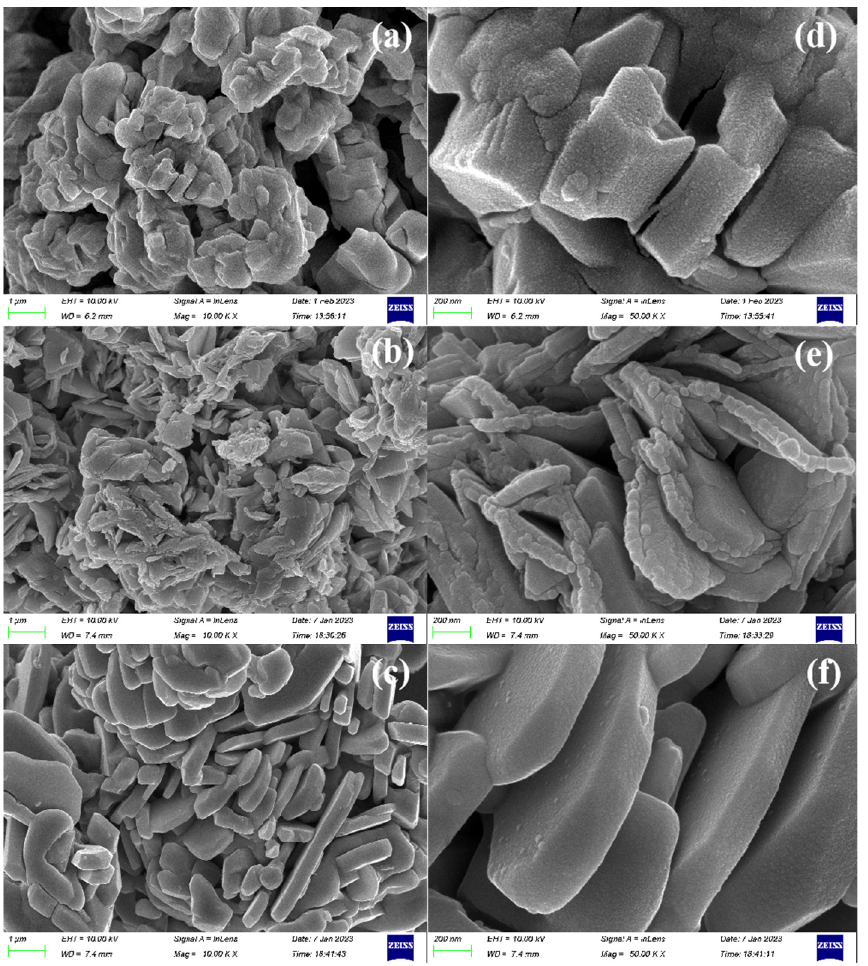
Figure 2. SEM images of Cu/MoO x samples with different atomic ratios of Cu/Mo ( a , d ) 1:2, ( b , e ) 1:1, and ( c , f ) 2:1.